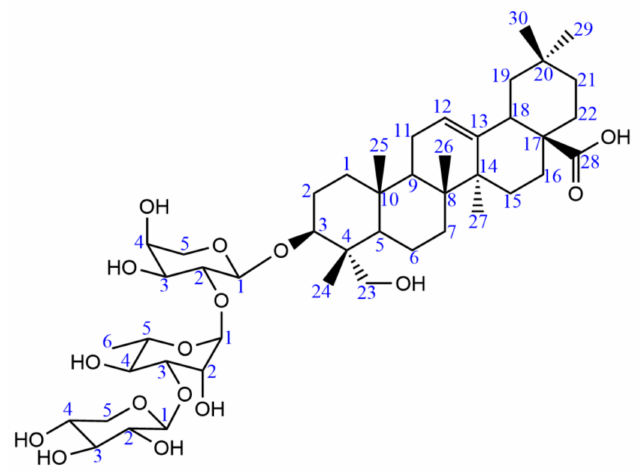
Figure 4. Chemical structure of compound A.